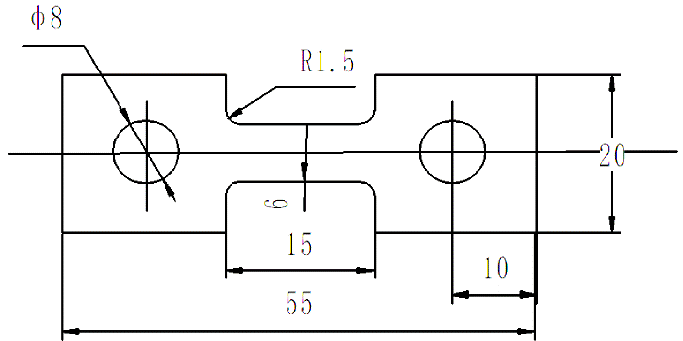
Figure 1. Schematic diagram of the superplastic tensile specimen (Unit: mm).